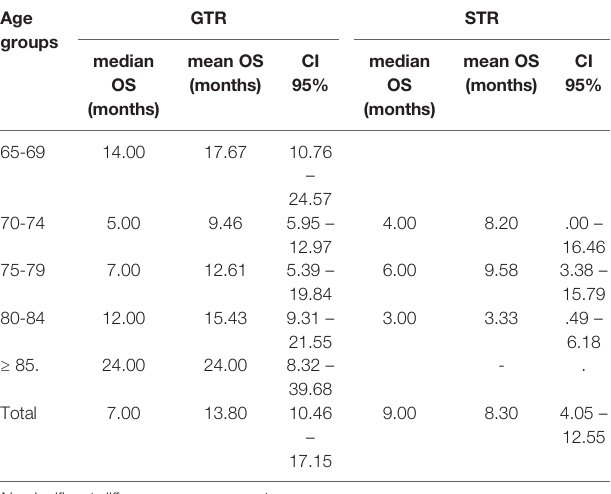
TABLE 3 | Mean and median OS in different age groups receiving GTR and